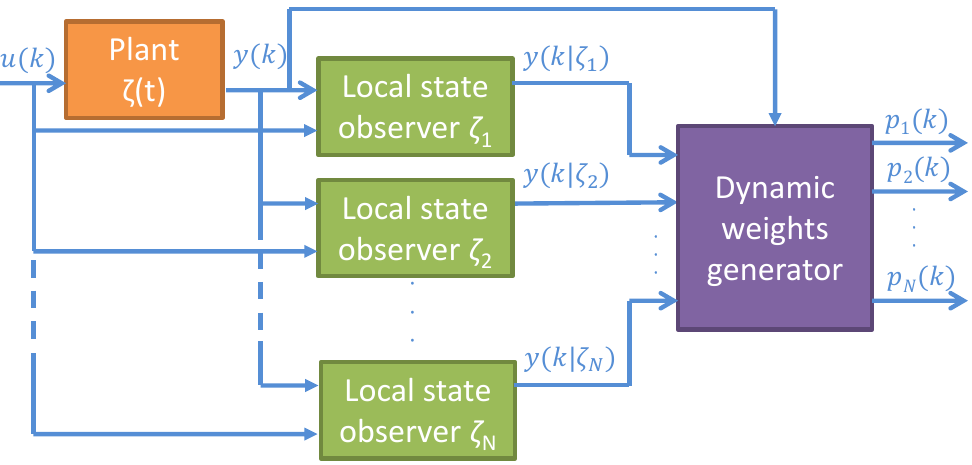
Figure 7. Multiple model adaptive estimator (MMAE) conceptual